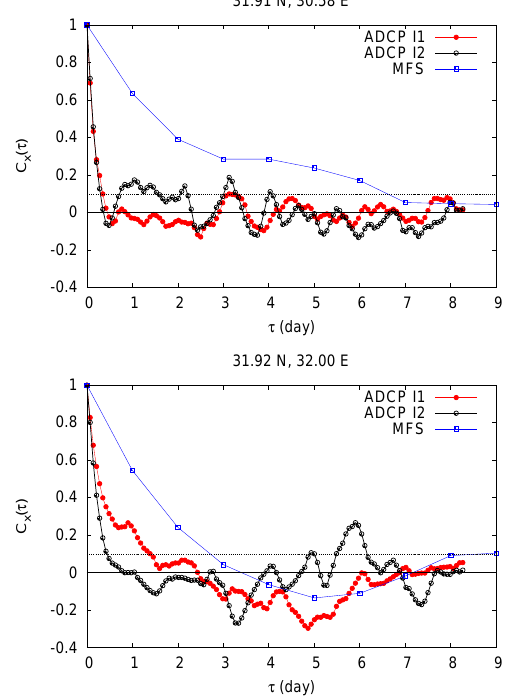
Figure 2. Log-lin plot of the velocity gradient autocorrelation func- tions versus the time lag. All data refer to the γ (cid:48) x (t) component. Top plot is for the ADCP located at 31.91 ◦ N, 30.58 ◦ E; bottom plot is for the ADCP located at 31.92 ◦ N, 32.00 ◦ E. Symbols: filled circles are for ADCP data of the period I1, February–April 1999; empty circles for ADCP data of the period I2, December 1999–February 2000; squares are for the MFS data averaged over period I1 and I2. Dotted lines indicate the value